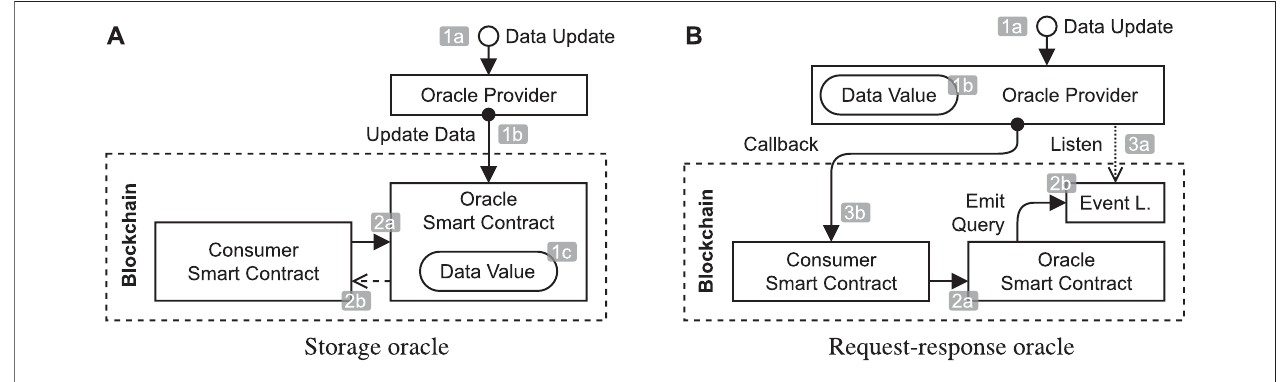
FIGURE 3 | Architecture and behavior of the storage and request/response